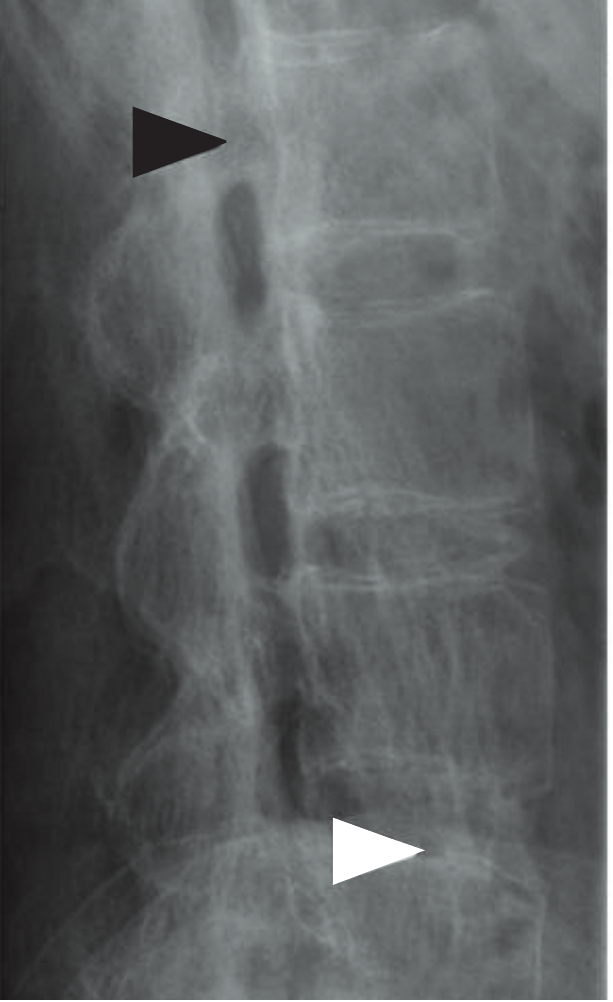
Fig 1. Lateral lumbar spine view. Note the ‘squaring’ of the lumbar vertebrae (open arrowhead), together with the central radio-dense region in the vertebral endplate of the 5th lumbar vertebra, superiorly (white arrowhead). This is known as an Andersson